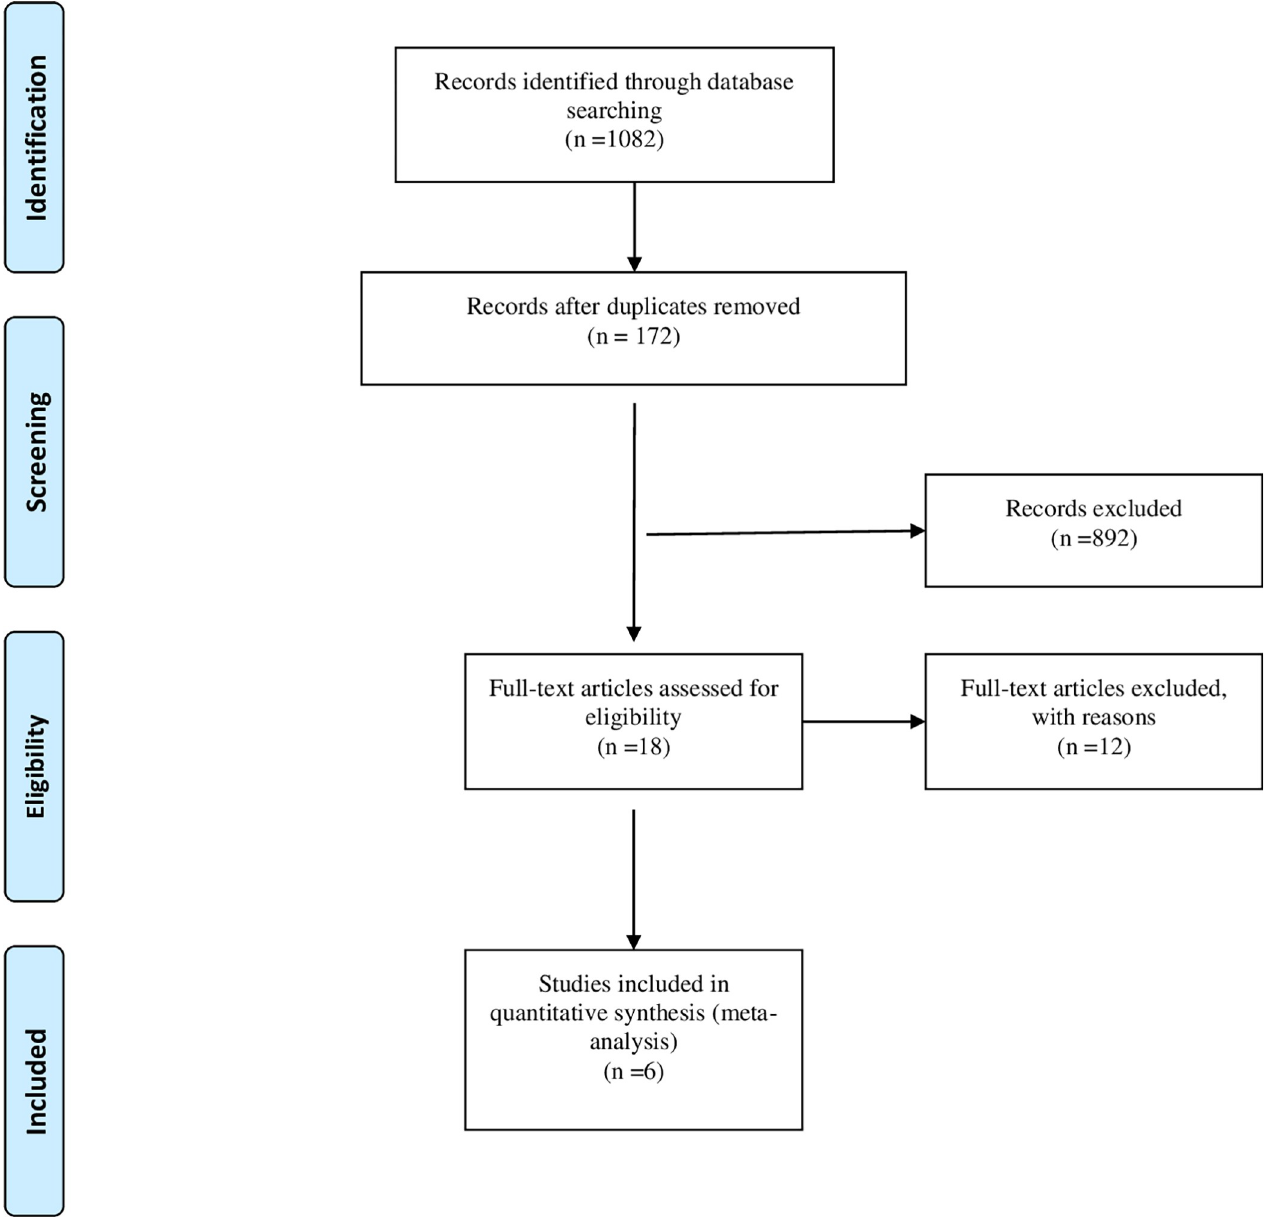
Fig 1. Study selection PRISMA